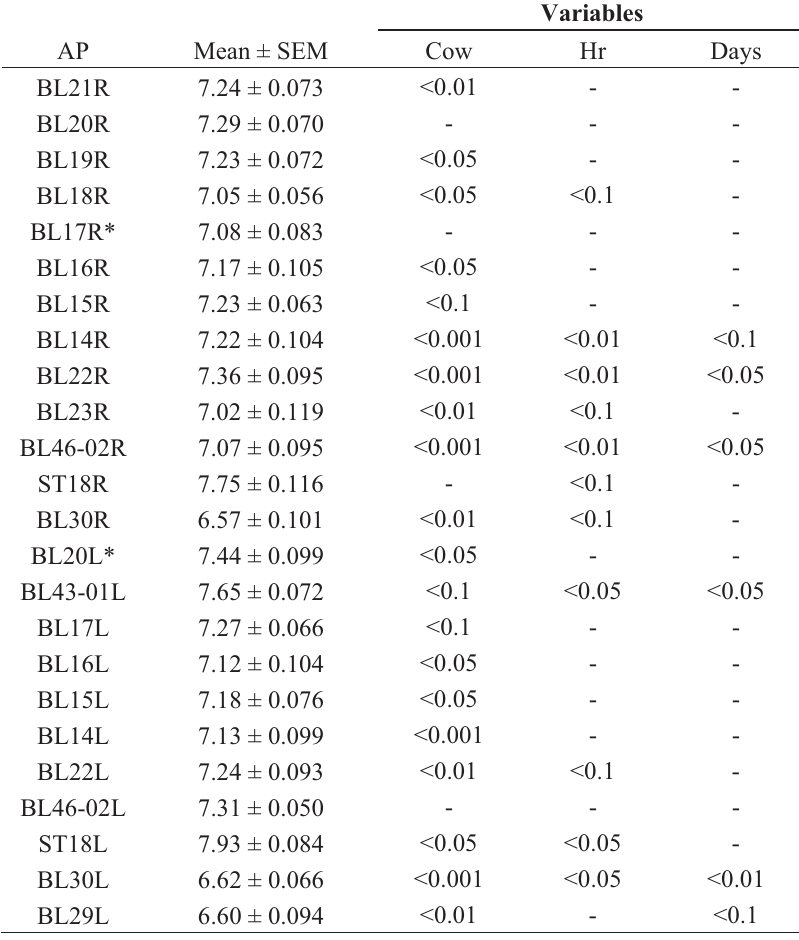
Table 3. Results of the ANOVA (P) for the log-transformed impedance values (in k(cid:4)) for the cow, within-day (Hr), and between-day